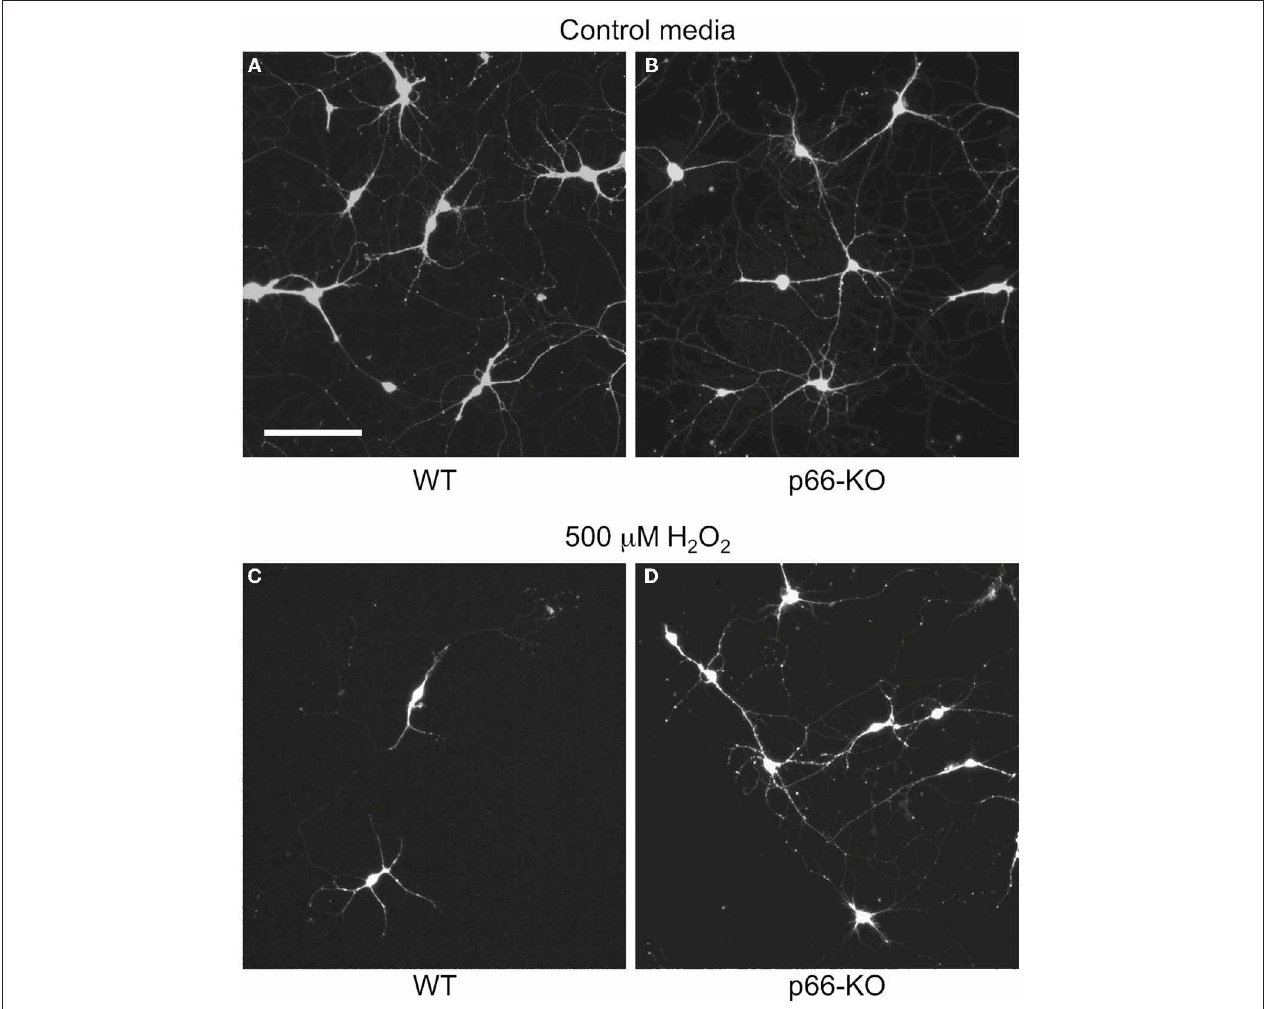
FIGURE 2 | p66-KO neurons show greater preservation of neuronal structure compared to WT neurons following H 2 O 2 treatment. Representative images of week-old p66-KO and WT neurons at 24h post-treatment with either control media (A,B) or 500 μ M 2 2 (C,D) ; viable